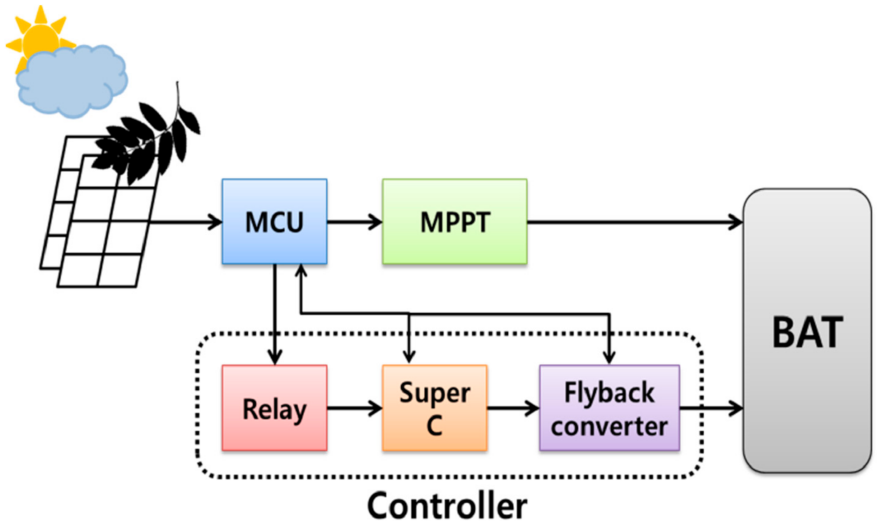
Figure 2. Diagram of the solar charge